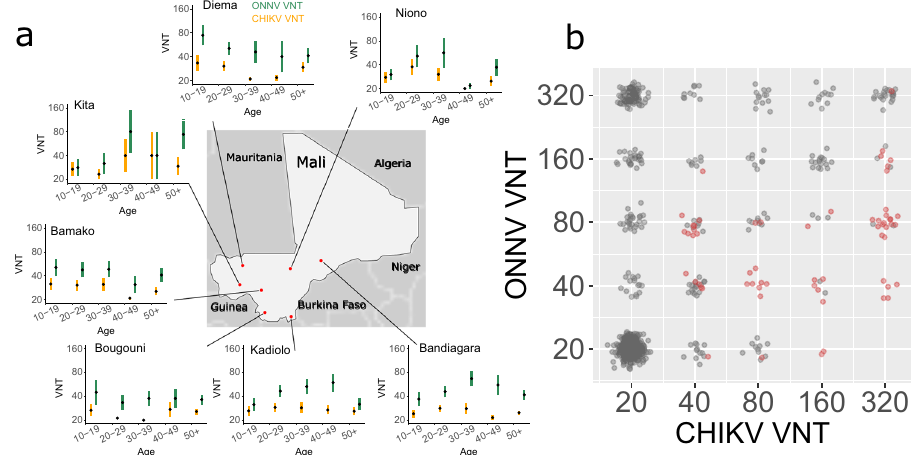
Fig. 1 Serology of CHIKV and ONNV in Mali. a Map of the seven sampling sites in Mali and virus neutralization titer (VNT, mean and standard error of the mean) of CHIKV (orange) and ONNV (green) by age in each site. Sample size for each age group and location is given in Supplementary Table 2. b Paired serology of CHIKV and ONNV in Mali (gray) and Martinique